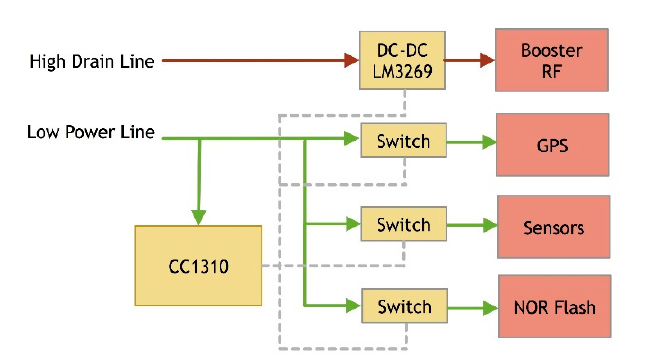
Figure 4. Power management